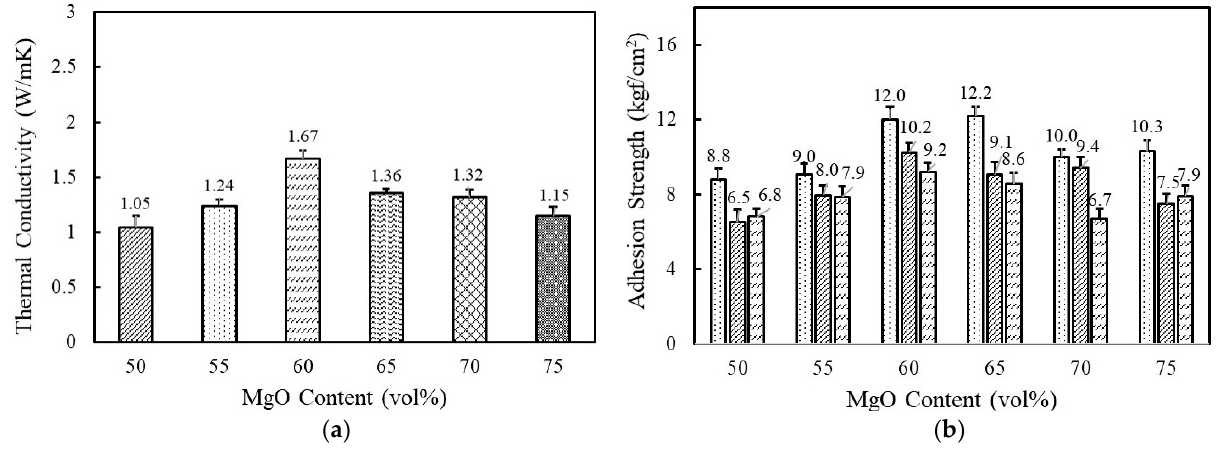
Figure 3. The thermal conductivity and adhesion strength of fluorosilicone adhesives as a function of MgO content: ( a ) thermal conductivity of fluorosilicone adhesives; ( b ) adhesion strength of fluorosilicone adhesives measured at 23 °C, 180 °C, and 250 °C.